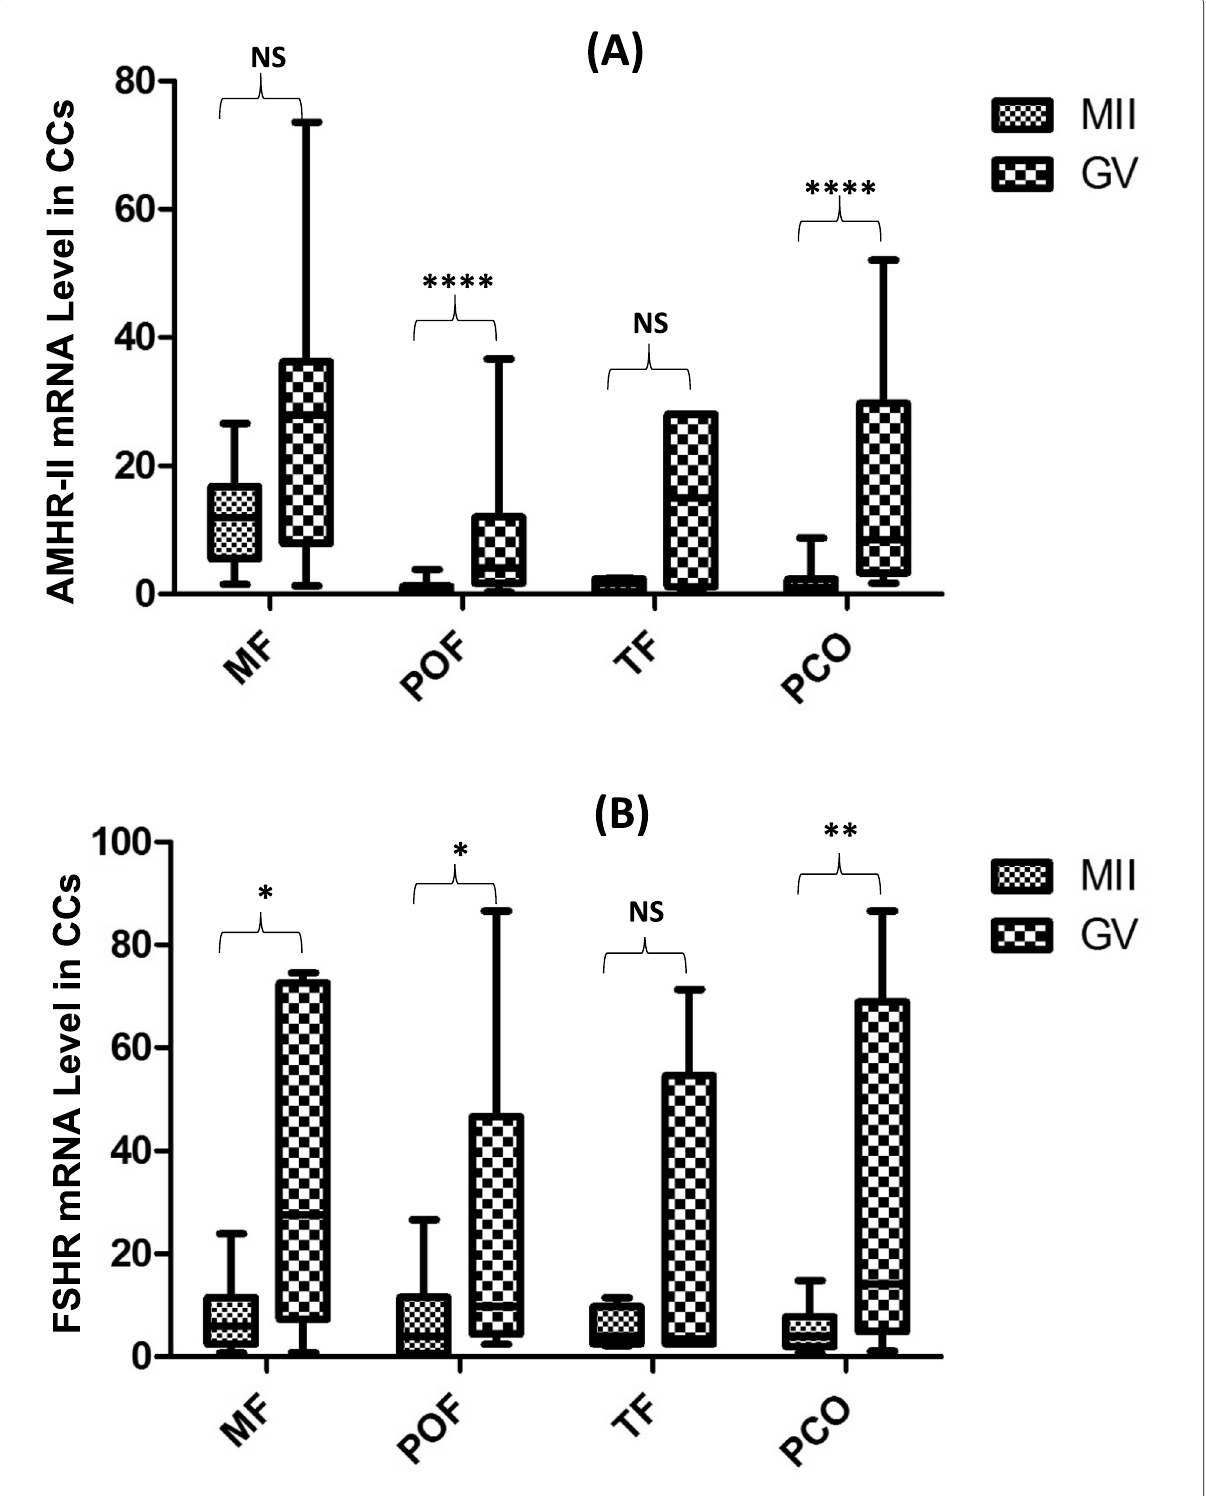
Fig. 2 Comparison of gene expression levels in CCs between groups based on their etiological patient subgroups. PCOS, polycystic ovarian syndrome; TF, tubal factor; POF, premature ovarian factor; MF, male